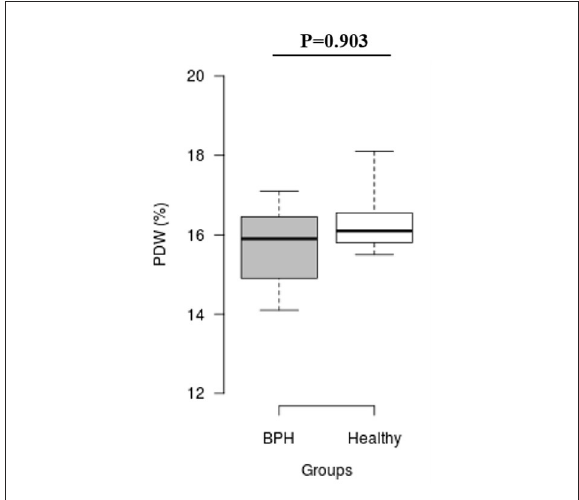
FIGURE6 Box plots of platelet distribution width (PDW) in BPH and Healthy groups Center lines show the medians; box limits indicate the 25th and 75th percentiles. n = 24, 11 sample points.